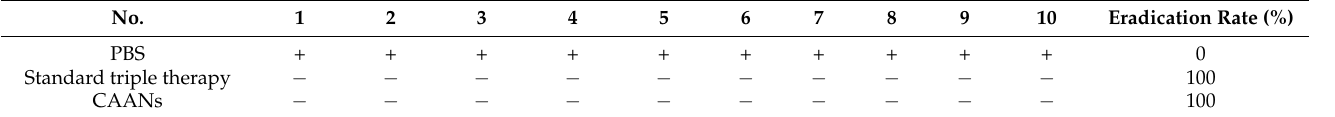
Table 2. In vivo eradication rate of different treatments of H. pylori with the MIC value of 0.016 µ g/mL.